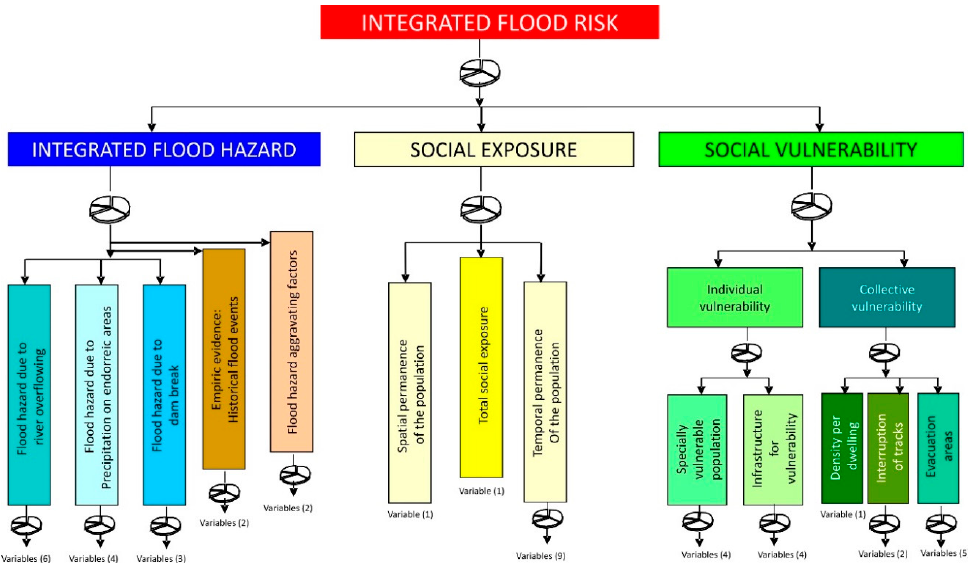
Figure 2. Diagram of the main variable groups used for the flood risk analysis of PRICAM project.